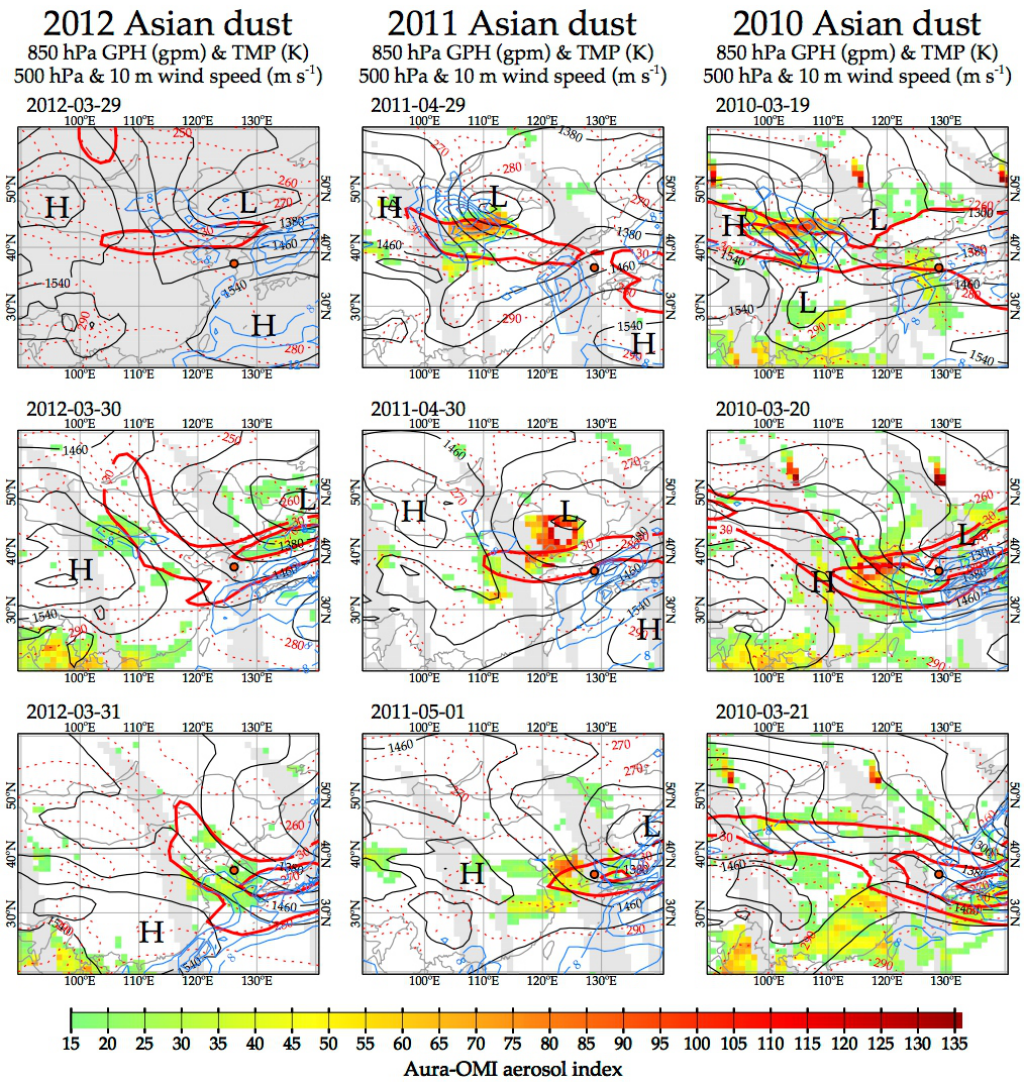
Fig. 7. Daily evolution of the 2010, 2011, and 2012 dust events with ERA-Interim daily meteorological fields superimposed on an Aura-OMI aerosol index over East Asia. Black solid lines and red dotted lines represent the 850hPa geopotential height (gpm) and temperature (K). Blue thin solid lines and red thick solid lines indicate 10m wind speed above 8ms − 1 and 500hPa wind speed above 30ms − 1 , respectively. The solid orange circles are the TSP sampling sites. Missing values of the OMI aerosol index are shown in light gray